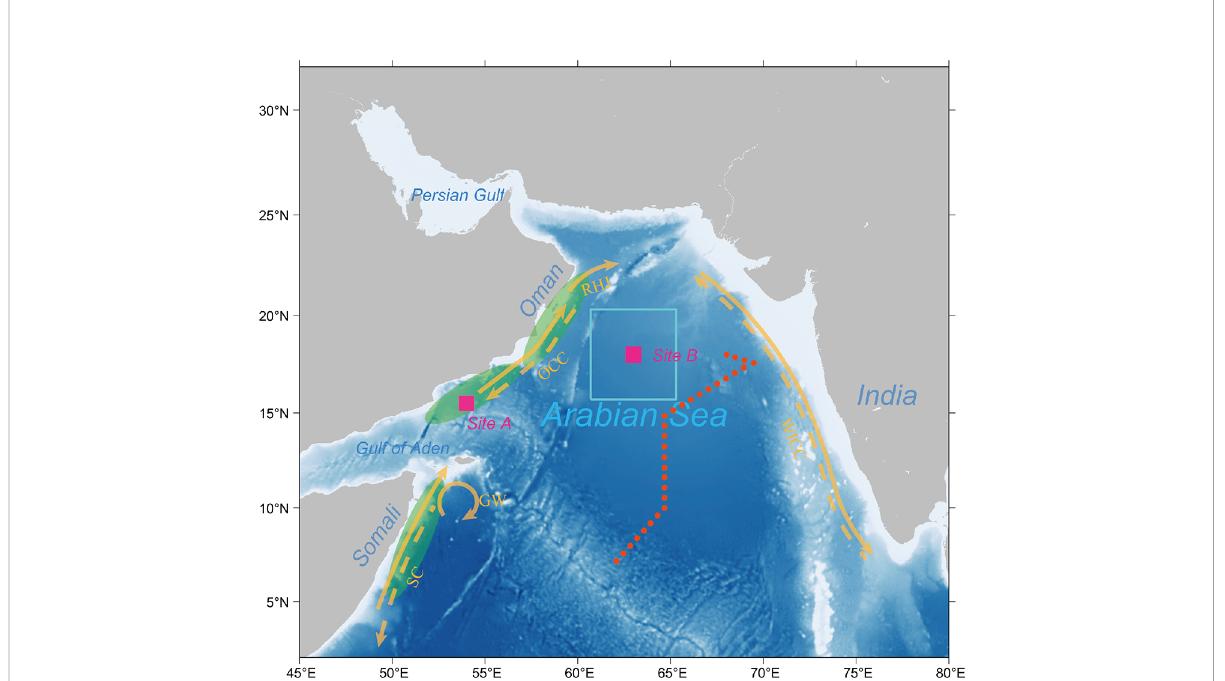
FIGURE 1 Map of the Arabian Sea and its adjacent seas. Coastal upwelling systems (green shading) and coastal circulations, after Schott and McCreary (2001). The solid (dashed) arrows represent the Somali Coastal Current (SC), the Great Whirl (GW), the Oman Coastal Current (OCC), Ras al Hadd Jet (RHJ), and the West Indian Coastal Current (WICC) in the winter (summer) monsoon state. Red dots represented the cruise track of the I07N cruise supported by the GO-SHIP in April – June 2018. Two squares represent the two sites (i.e., sites A and B) selected for